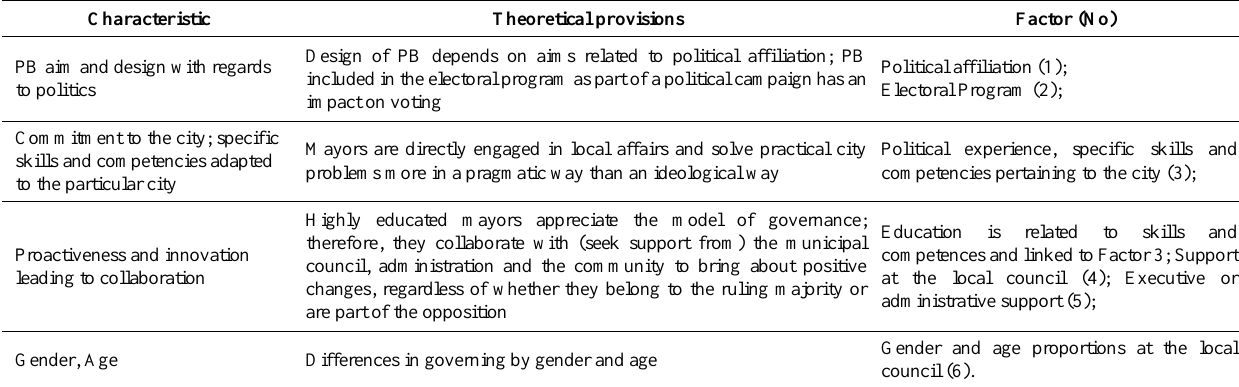
Table 1. Characteristics and research